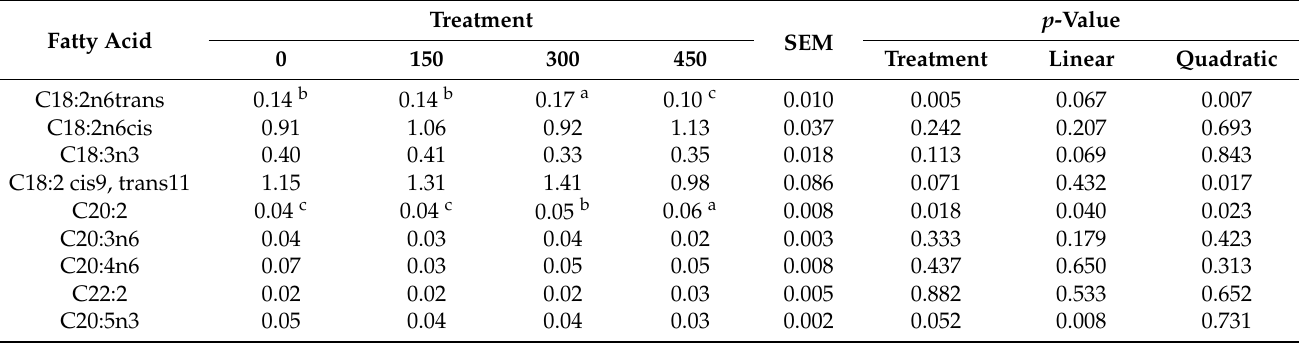
Table 3. Polyunsaturated fatty acids (g/100 g of total fatty acids) in milk from crossbred F1 dairy cows fed on tropical grasses and supplemented with different levels of concentrate (0, 150, 300 and 450 g of DM concentrate/kg of daily milk production).